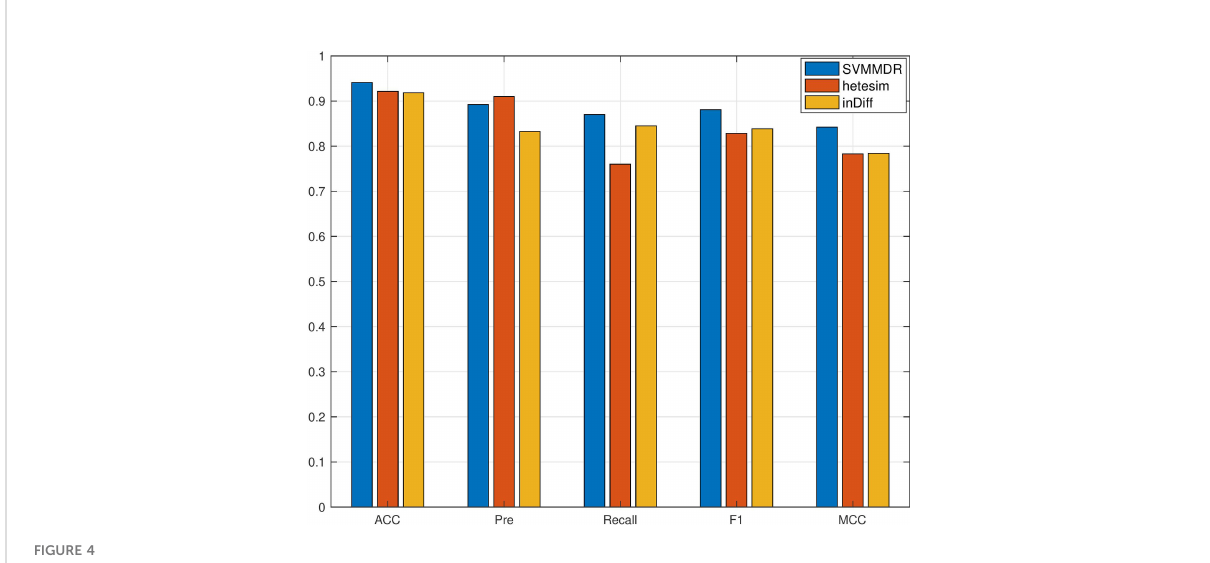
FIGURE 4 The performance comparison with different feature.